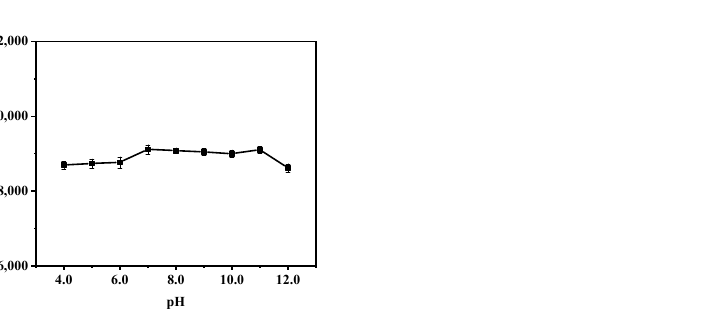
Figure 6. Elution efficiency of the different number of elution times (each elution operation was performed for 10 min). performed for 10 min).